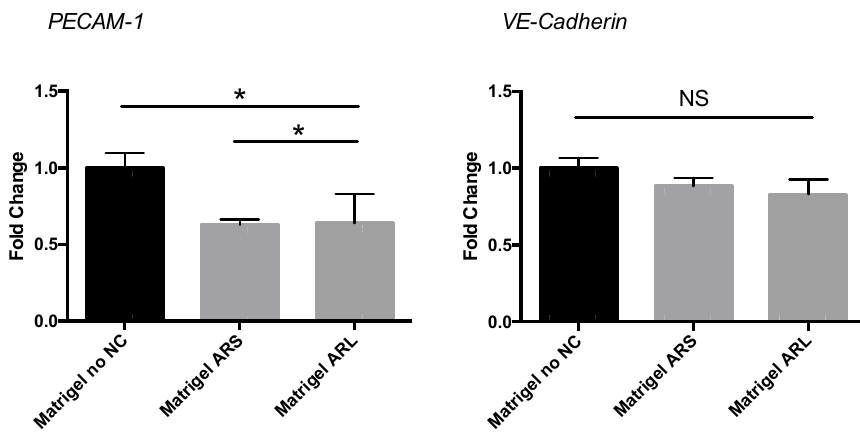
Figure 6. Quantitative real time PCR of angiogenic gene expression in HUVECs on Matrigel with NCs. Results are expressed as mean values ± S.D. * statistical significance at the level of p < 0.05.